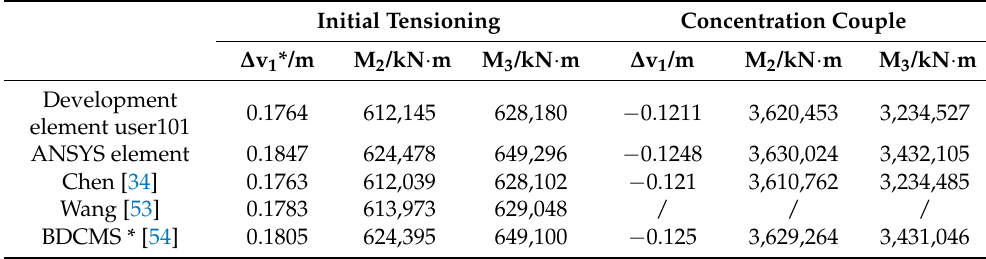
Table 4. Deformation value of square frame under concentrated